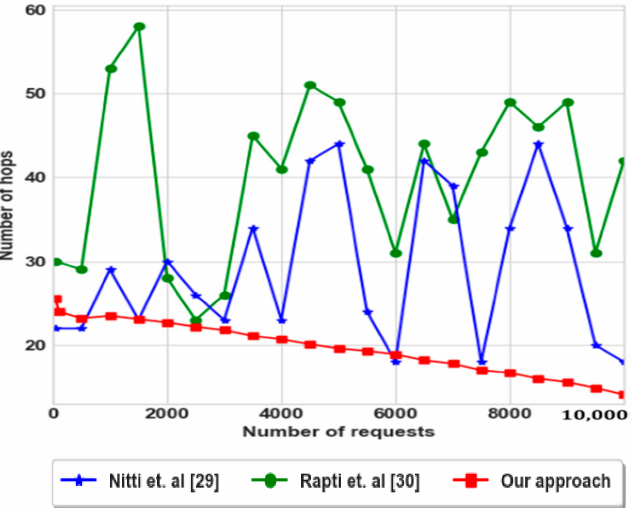
Figure 11. Number of hops to find the provider node according to the number of